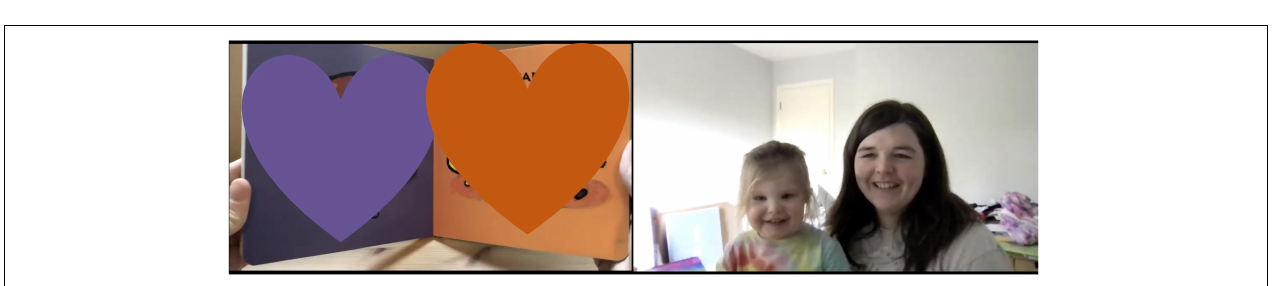
FIGURE 5 | Adjusting size of participant’s screen in